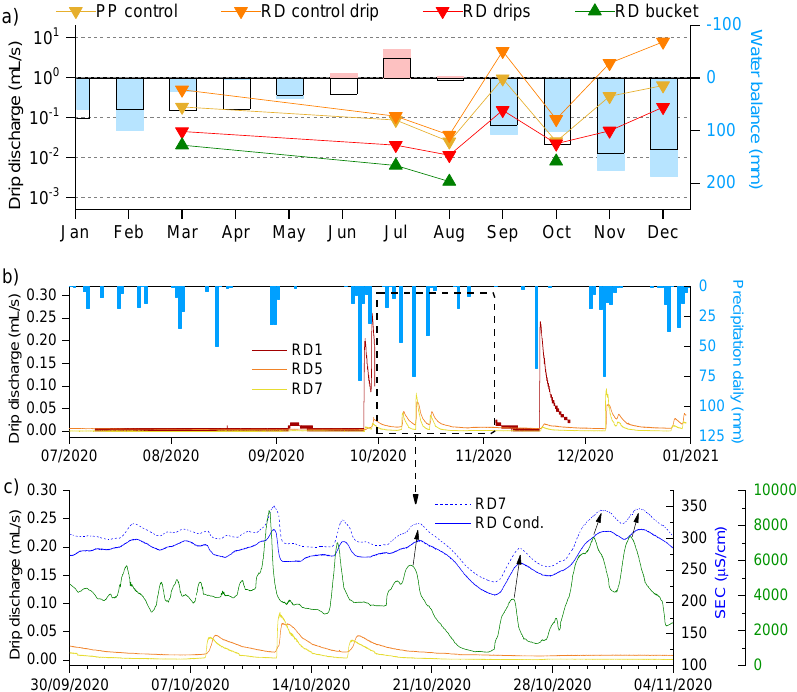
Figure 6. ( a ) Time series of the drip discharge and water balance on a monthly basis summarised for the period 2017–2020. The blue and red columns show the positive and negative water balances (excess or deficit, respectively), calculated as the difference between precipitation and net evapotranspiration (calculated with the Penman-Monteith equation) [37]. The black boxes show the climatic averages (1981–2010). ( b ) A 6-month window of the drip response to precipitation events (blue bars on a daily scale). The seepage flow with a fracture-fed component is represented by RD1 (red curve), while the seepage flow with a typical diffuse component is represented by RD5 and RD7 (orange and yellow curves). Both diffuse drips did not respond to summer precipitation, while RD1 showed a very low response. The precipitation data are from the Postojna National Meteorological Station, located 2.5 km SSW of Pisani Passage [37]. ( c ) Inset from ( b ) showing a higher resolution in a shorter time frame with continuous electroconductivity (SEC) from the RD Cond. and RD7 cups (dashed and solid blue curves) and p CO 2 on the cave floor (green line). The lag time between the p CO 2 peaks and the responses to the SEC peaks ranges from a few hours to about 12 h (marked by black